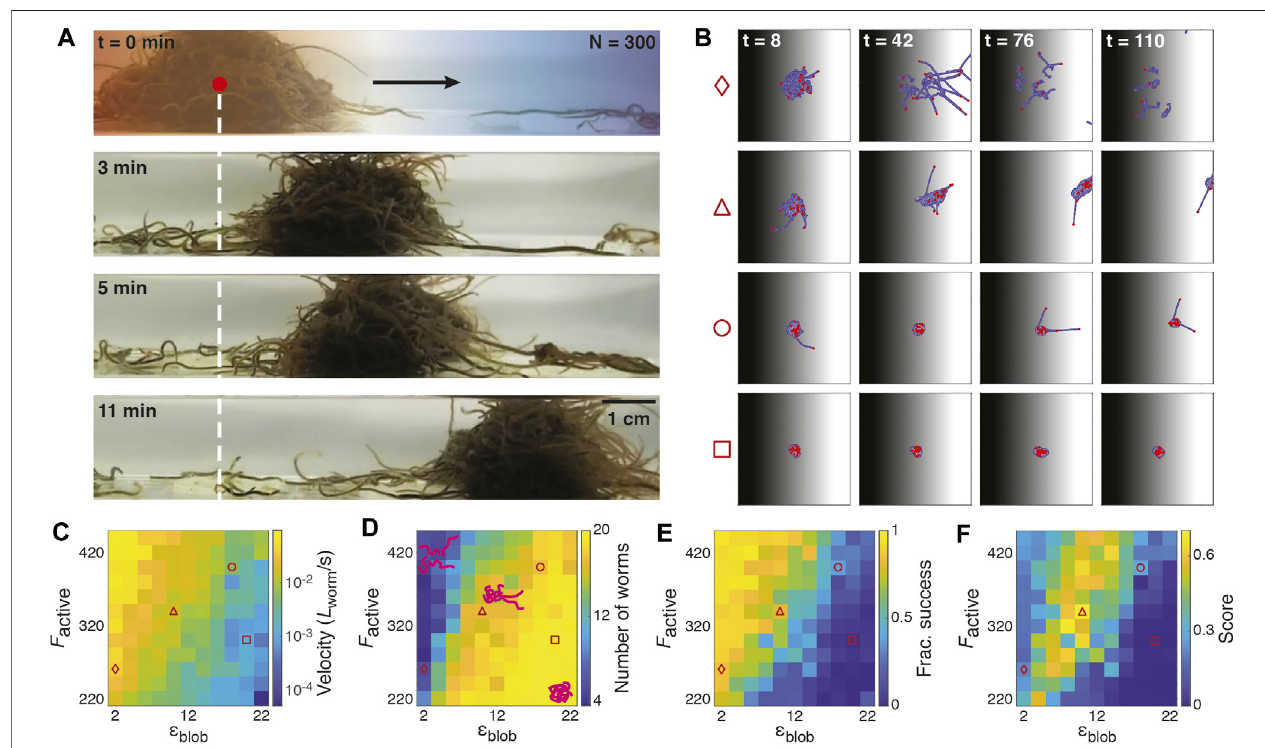
FIGURE4| Emergentlocomotionintemperaturegradients. (A) :Snapshotsofanexperimentalwormblob( N (cid:1) 300worms)demonstratingemergentlocomotionin a temperature gradient (left: high temperature; right: low temperature). (B) : Snapshots ofblob in temperature gradient from T (cid:1) 0.08 (black) on the left to T (cid:1) 0 (white) on theright.Eachcolumncorrespondstoadifferentsimulationtimestep( t (cid:1) 8,42,76,and110respectively).Eachrowcorrespondstodifferentsetofattractionparameters ε ε (cid:1) 2, F (cid:1) 260; triangle: ε (cid:1) 10, F (cid:1) 340; circle: ε (cid:1) 18, F (cid:1) 400; square: ε (cid:1) 20, F (cid:1) blob and active force magnitudes F active (diamond: blob active blob active blob active blob active 300). Red dots indicate the heads of individual worms. Despite the three-dimensional nature of real worm blobs, our two-dimensional model captures emergent collective locomotion for some combinations of ε blob and F active : in the triangle sequence, the majority of worms collectively move from the hot side of the gradient to the cold side, with the heads of some worms extending into the cold side. (C) : Heatmap of the average x-component of the blob velocity (in worm length per second) for a range of F active and ε blob . The velocity is computed for the center of mass of the largest cohesive blob in the simulation. (D) : Heatmap of the average number of worms (maximum of 20) of the largest cohesive blob for a range of F active and ε blob . Cartoons indicate typical con fi gurations of worms for different regimes of parameter space. (E) :Heatmapofthefractionofsuccessfulwormspersimulation.Successisindicatedbythefractionofwormsthatreachthe T (cid:1) 0coldsideofthegradientbytheendofa 120-timestep simulation. (F) : Heatmap of the collective locomotion score, given by the product of the blob velocity, blob size, and fraction of success, with each term weighted so that its maximum is 1 ( Eq. 7